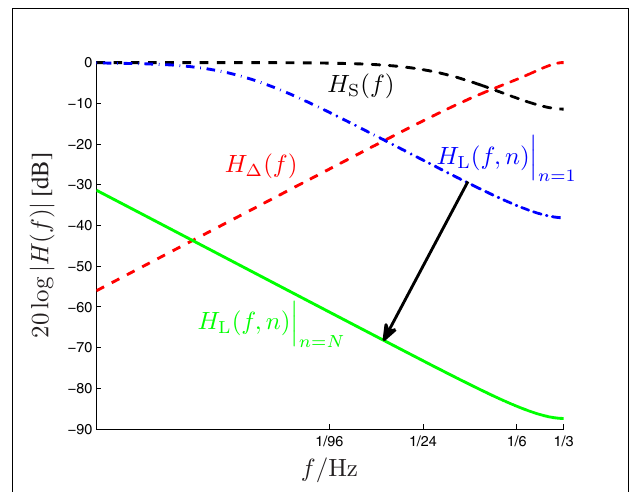
FIGURE 4 |Amplitude responses of the long-term ( H L ( f , n ), dash-dotted and solid low-pass curves), short-term ( H S ( f ), dashed low-pass curve) and alternation ( H (cid:49) ( f ), dashed high-pass curve) filters of the DIF model as a function of the input signal frequency f (logarithmic scale!). The dynamic long-term filter (dash-dotted and solid curves) is shown for n = 1 and n = N =